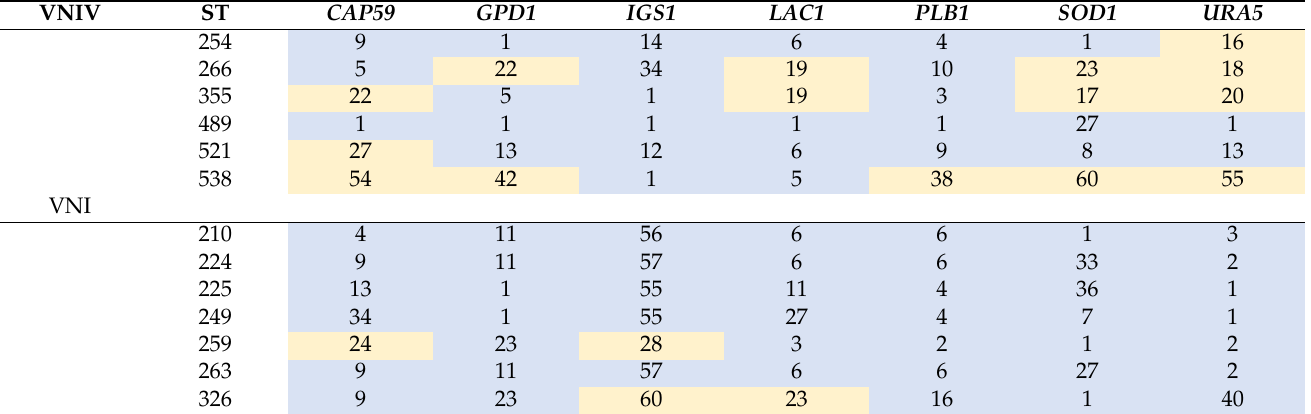
Table 4. Allelic profiles of STs with intermediate and inconsistent molecular type assignments between the original assignments in the MLST database and those based on the seven-gene phylogeny in Figure 1. Fifteen STs with mixed background colors are likely hybrids of serotypes A and